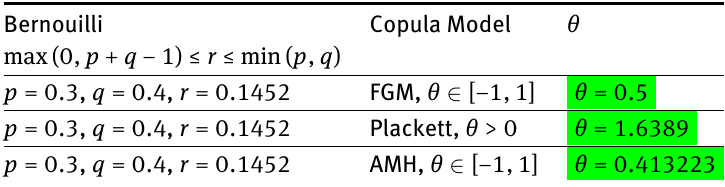
Table 2: Bernoulli distribution with several copula